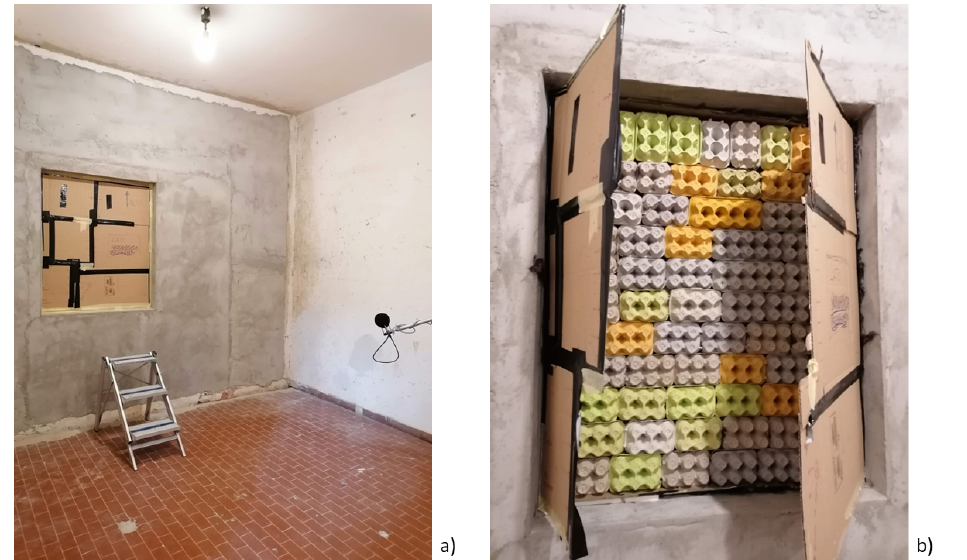
Figure 5. Panel installed in the sound transmission room ( a ) and details of the panel core ( b ). The panel filled with polyester is denoted as AC-T3-BP , and the panel filled with felt is denoted as AC-T4-BF7 .